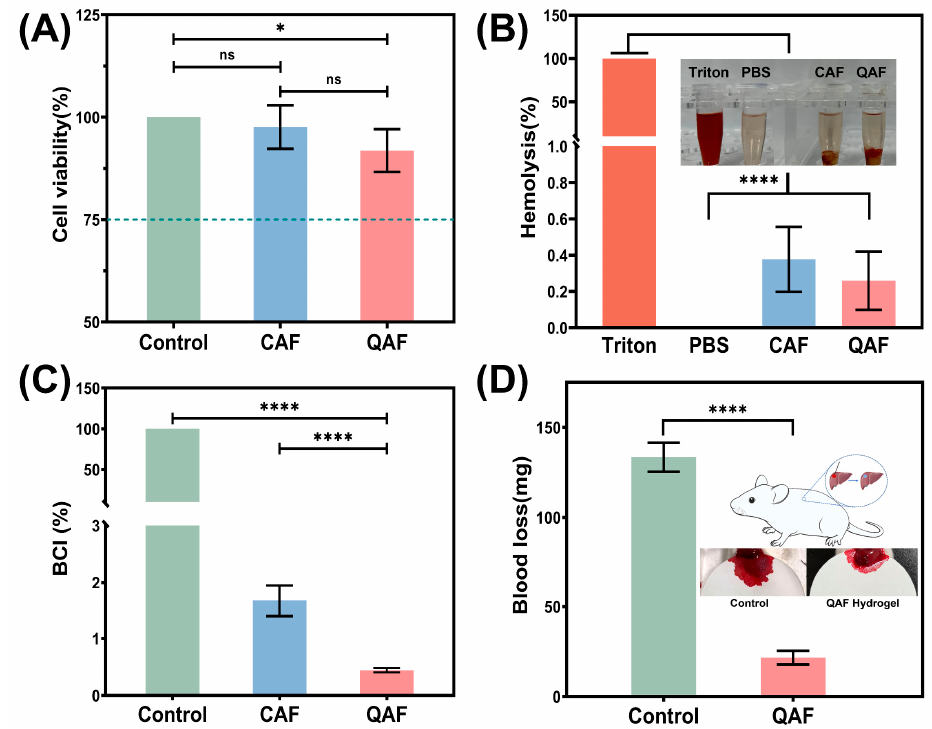
Figure 6. In vitro hemocompatibility evaluation. ( A ) Cell viabilities of L929 fibroblast cells ( n = 3); ( B ) Hemolysis performances of hydrogels ( n = 3); ( C ) The BCI values of whole blood clotting evaluation ( n = 3); ( D ) Hemostatic performances of QAF hydrogels in mouse liver hemorrhage model (The control mouse received no treatment, n = 3). ns > 0.05, * p < 0.05, **** p < 0.0001.